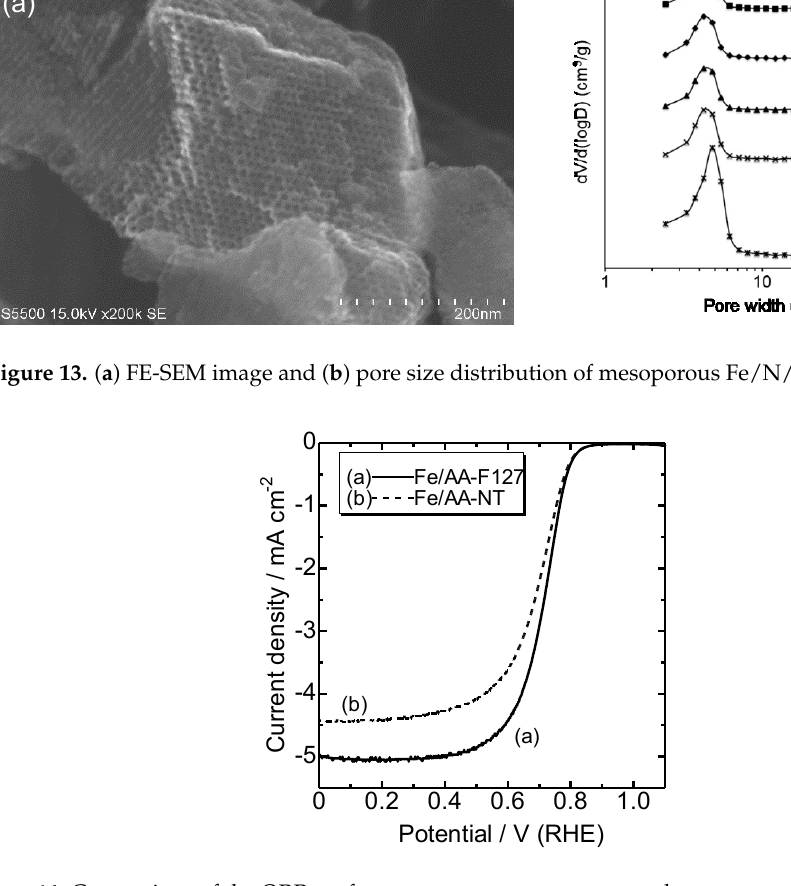
Figure 14. Comparison of the ORR performances at room temperature between catalysts prepared by copolymer-template carbonization and those prepared without using a template [56]. Catalyst loading: 0.2 mg cm −2 , electrolyte: O 2 saturated 0.5 M H 2 SO 4 , rotation: 1600 rpm.